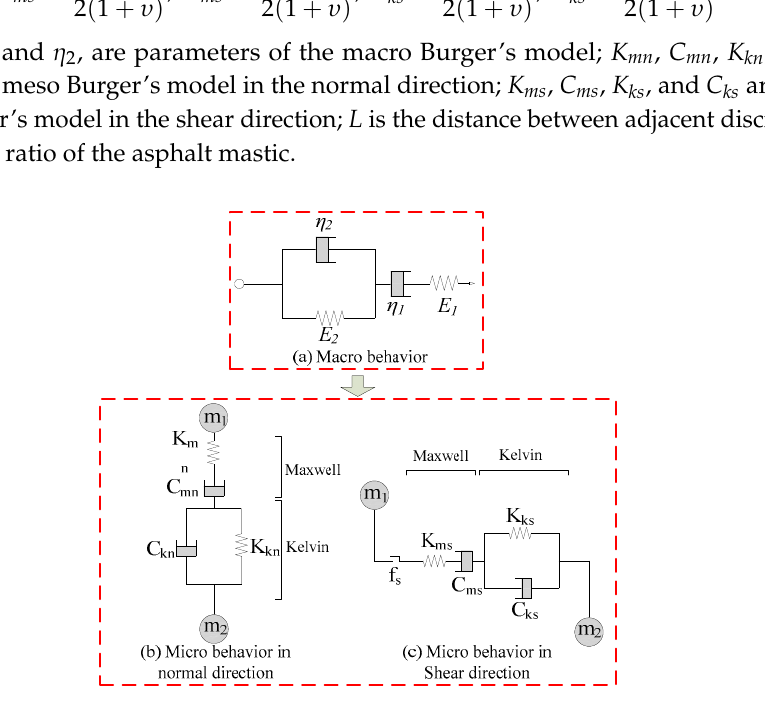
Figure 7. Burger’s models. ( a ) Macro behavior; ( b ) micro behavior in the normal direction; ( c ) micro behavior in the shear direction. Table 3. Macro parameters for asphalt mastic and aggregates.